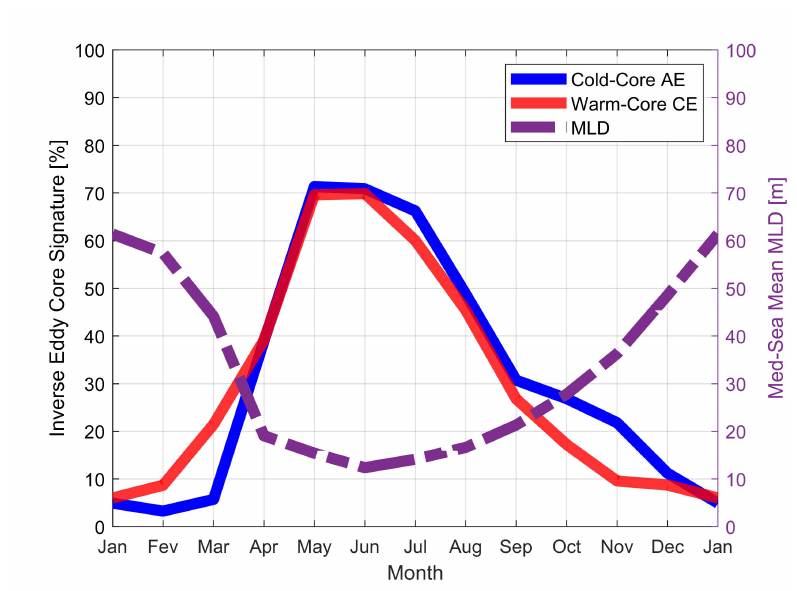
Figure 6. Seasonal variation of the mean MLD with inverse eddy anomaly percentage. For each month, the mean percentage of Cold Core AE observations is plotted with a blue line, the mean percentage of Warm Core CE observations is plotted with a red line, and the mean MLD of all Argo profiles located outside eddies with a dashed purple line.